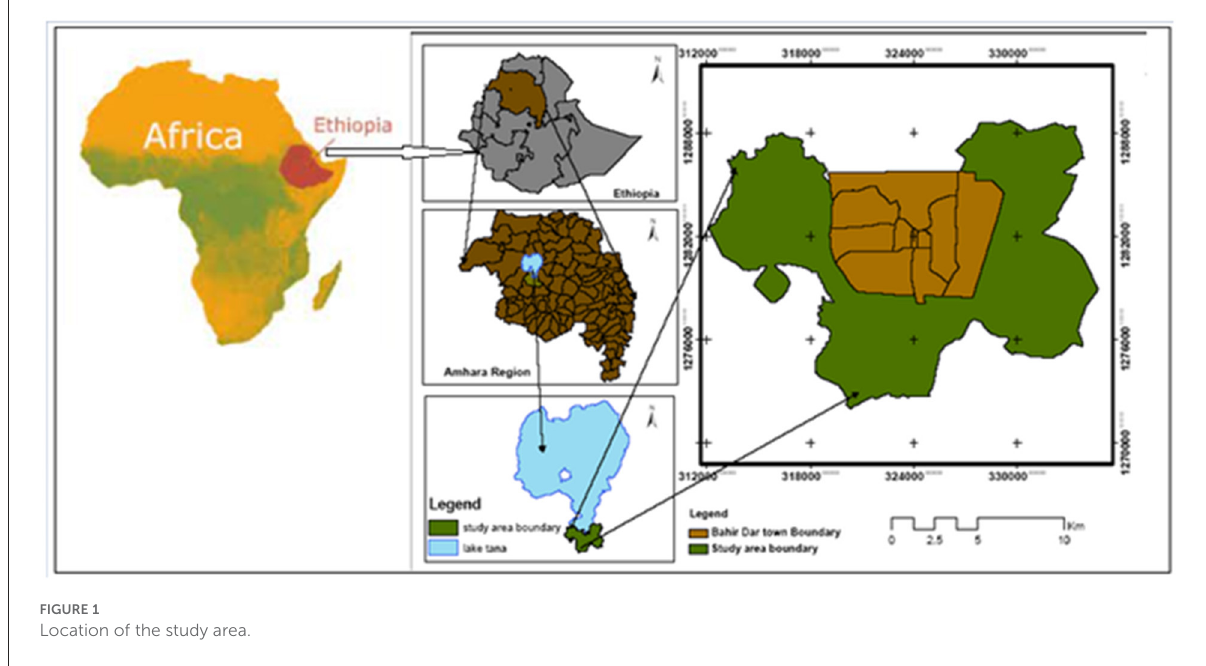
FIGURE1 Location of the study area.